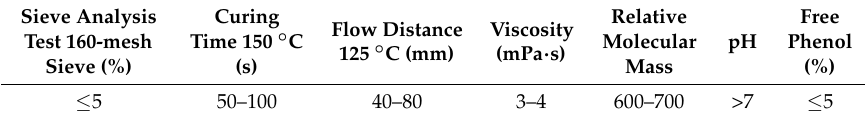
Table 3. Specifications of the resin used in brake composites.